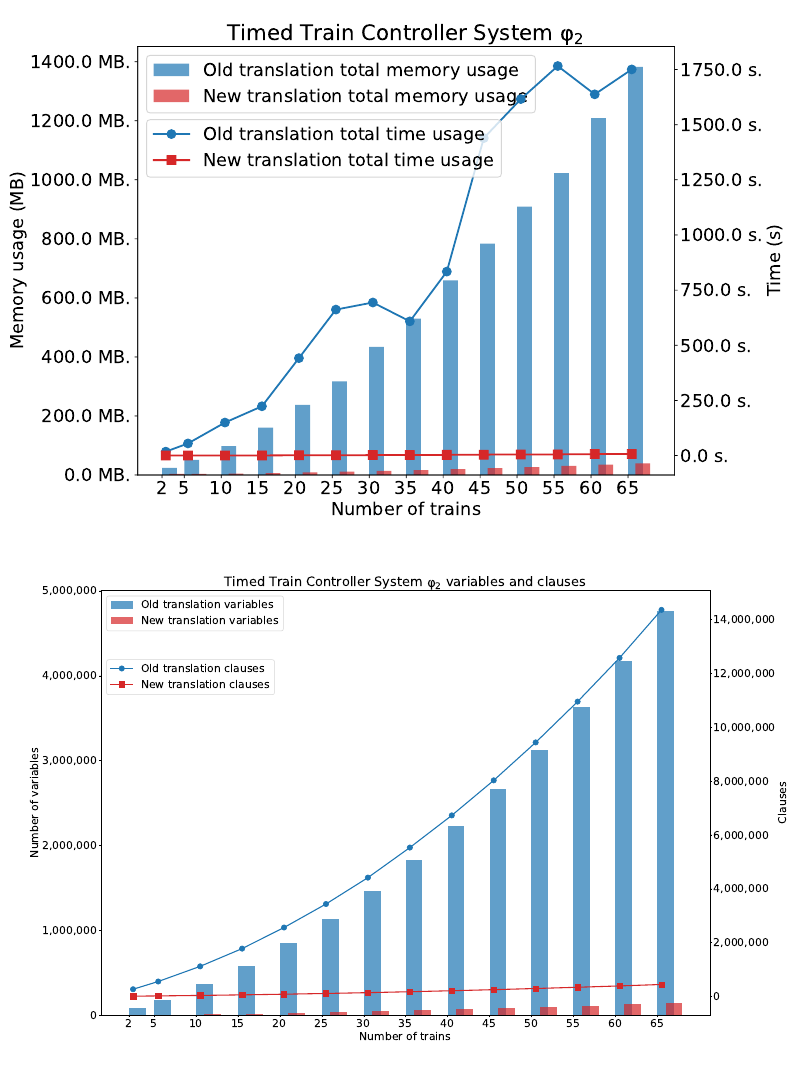
Figure 14. Results for ϕ 2 . Number of variables and clauses for ϕ 2 and TTCS with n